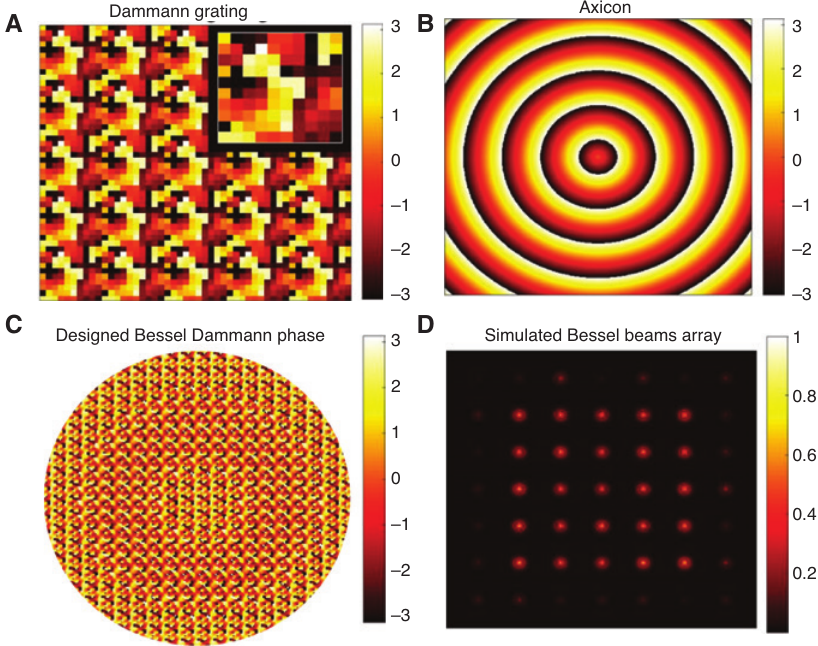
Figure 2: Simulation results of Bessel beam array. The following is the design process of the metasurfaces and Bessel beam generation: (A) fractional phase profile of the Dammann grating (the inset is the optimized phase distribution within one supercell); (B) phase profile of axicon; (C) final Bessel phase profile by integrating Dammann grating with axicon function; and (D) numerical reconstruction of Bessel beams by using Fresnel